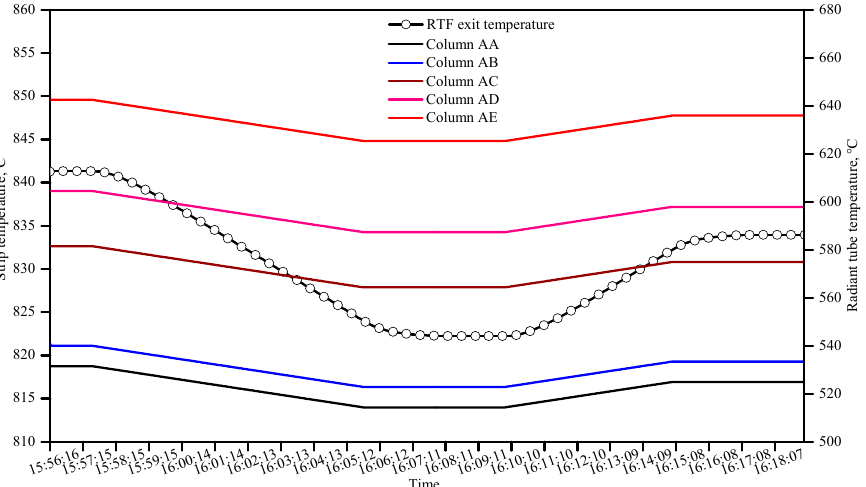
Figure 10. Response of strip temperature at RTF exit when radiant tube temperature of each column changes.